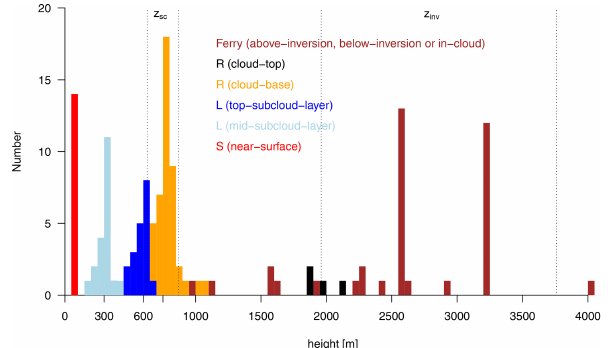
Figure 4. Vertical distribution of the number of R, L, S and ferry patterns flown by the ATR during the whole EUREC 4 A campaign. Also reported are the ranges of subcloud-layer top heights ( z sc ) and inversion heights ( z inv ) derived from dropsondes (Table